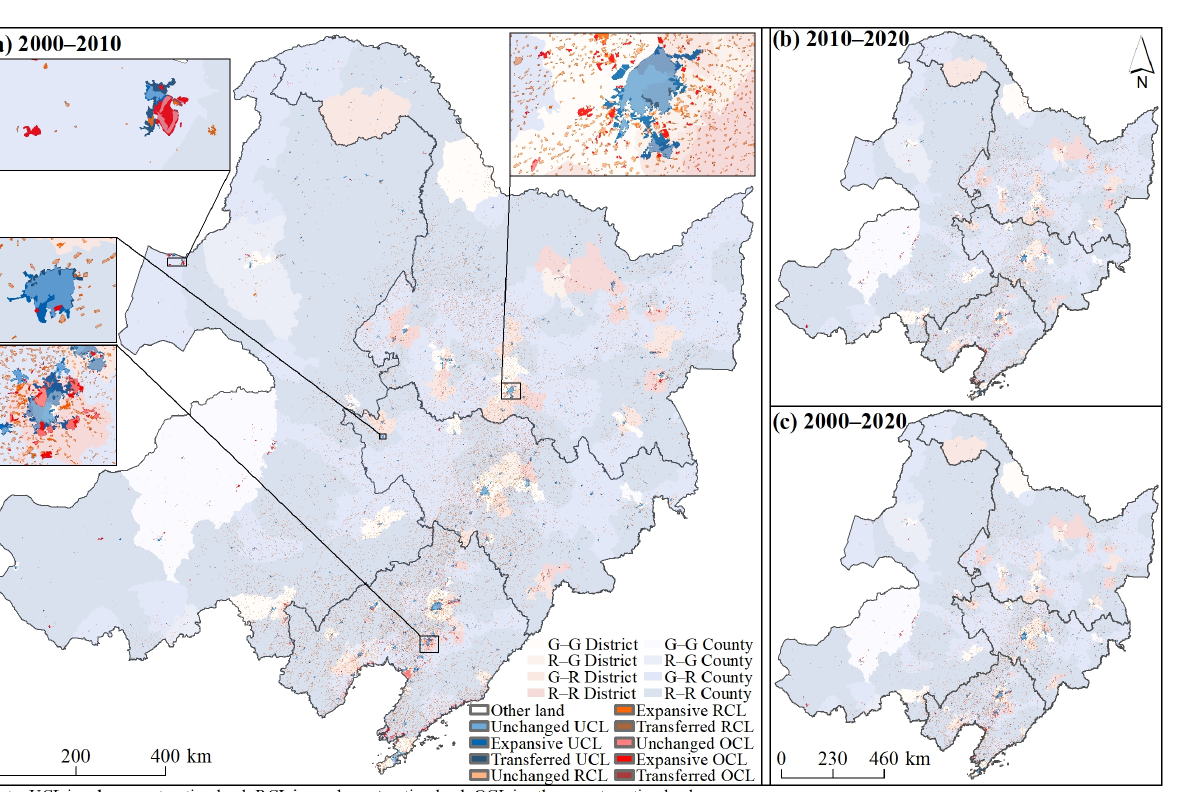
Figure 6. Spatial patterns of construction land change in northeast China. (Due to the large research area, some small patches cannot be clearly seen under the required resolution. Inset maps are used to clarify details in four provinces). ( a ) 2000–2010; ( b ) 2010–2020; ( c ) 2000–2020.